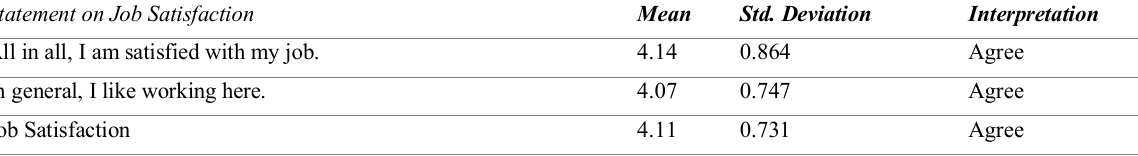
Table 5: Mean of statement on job satisfaction